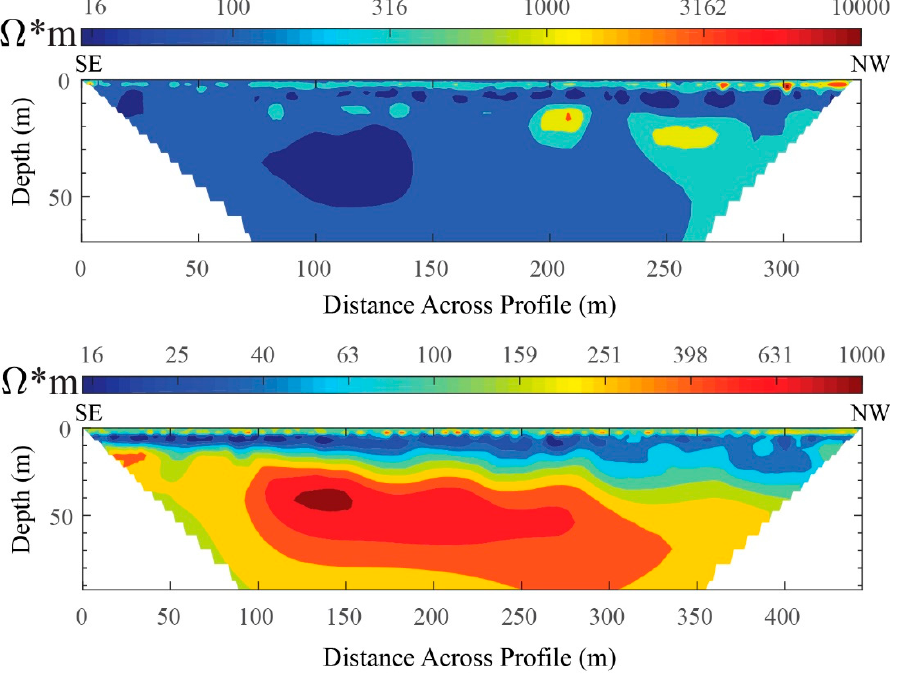
Figure 2. Inverted electrical resistivity models. From left-to-right, both profiles traverse an SE to NW trend (Figure 1A,B). Top: Control Meadow. Bottom: Marian Meadow. Color bars on each panel cover di ff erent ranges of resistivity. The Control Meadow image is 333 m long with an image depth of 69 m. The Marian Meadow image is 444 m long with an image depth of 92 m.